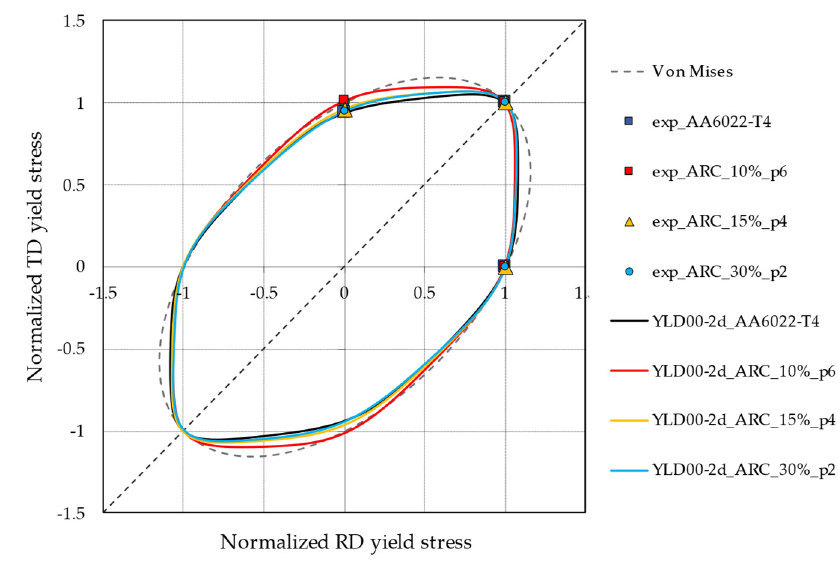
Figure 15. Evolution of the yield surface of AA6022 ‐ T4 ‐ T4 with rolling.